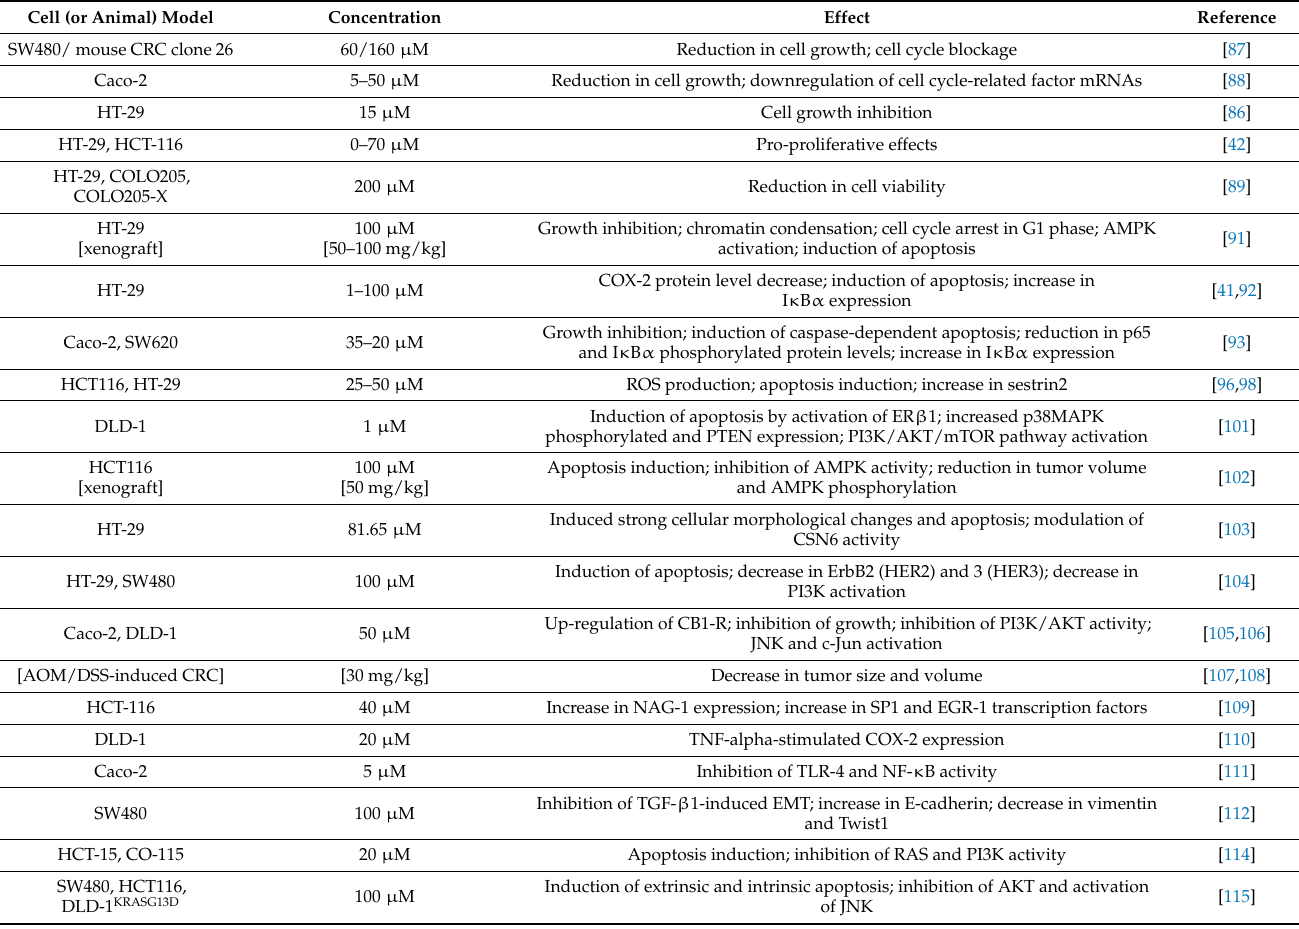
Table 4. Targets affected by quercetin free form in CRC experimental